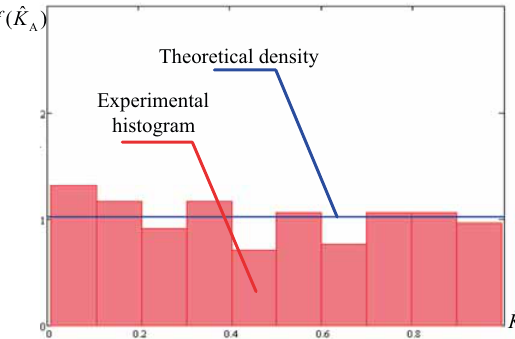
Fig. 8. PDF and histogram of the ready-to-operate factor estimation for the